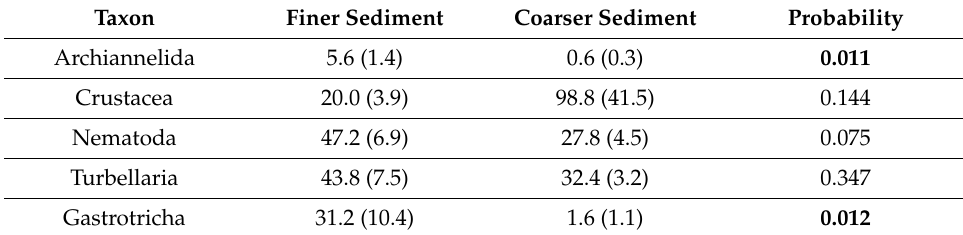
Table 6. Parameters of linear regressions of ln-transformed abundances of major taxa onto depth with sediment type as a cofactor. When the interaction of the overall model is significant the parameters of the separate regressions (finer or coarser) are presented. ns — p > 0.05, *— p < 0.05, **— p < 0.01, ***— p < 0.001.